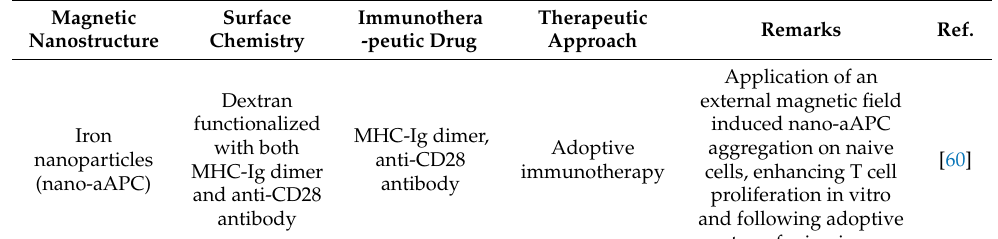
Table 1. Overview of the different magnetic nanostructure-based combinatorial immunotherapy ap-